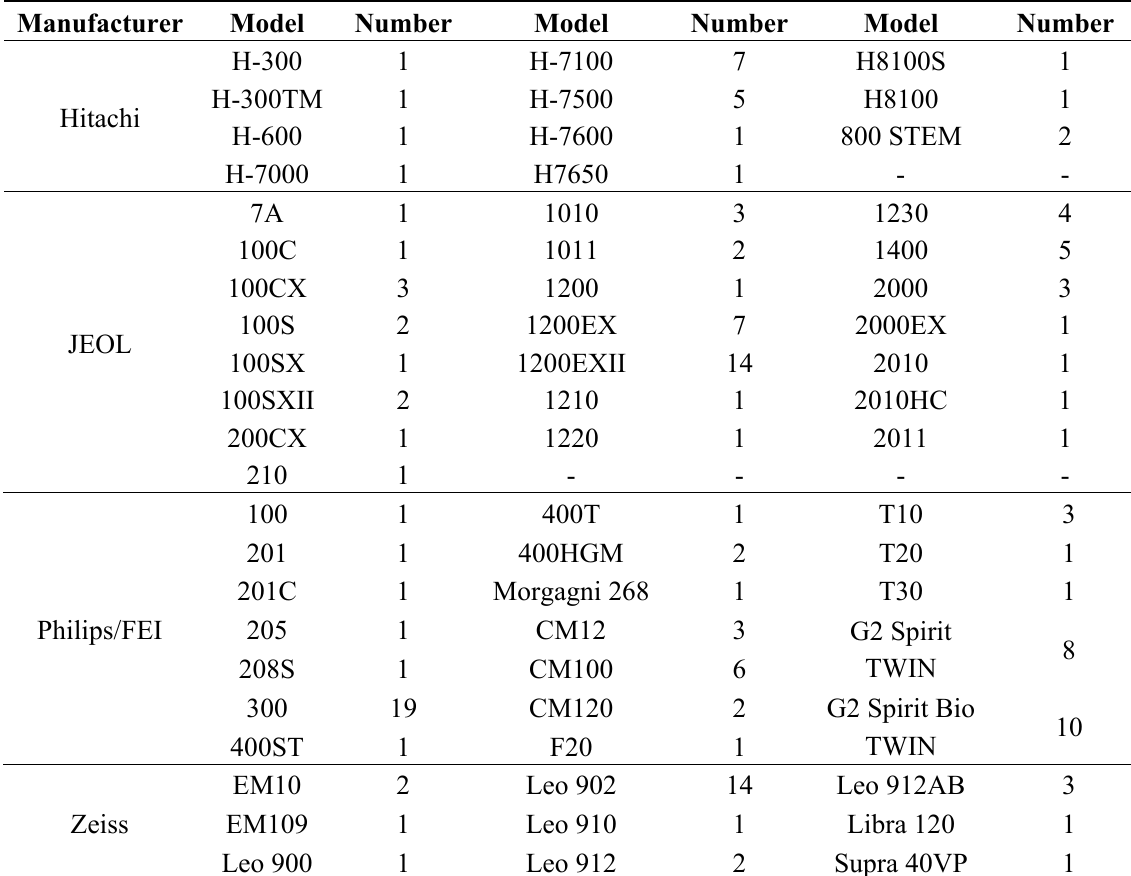
Table 3. Electron microscopes